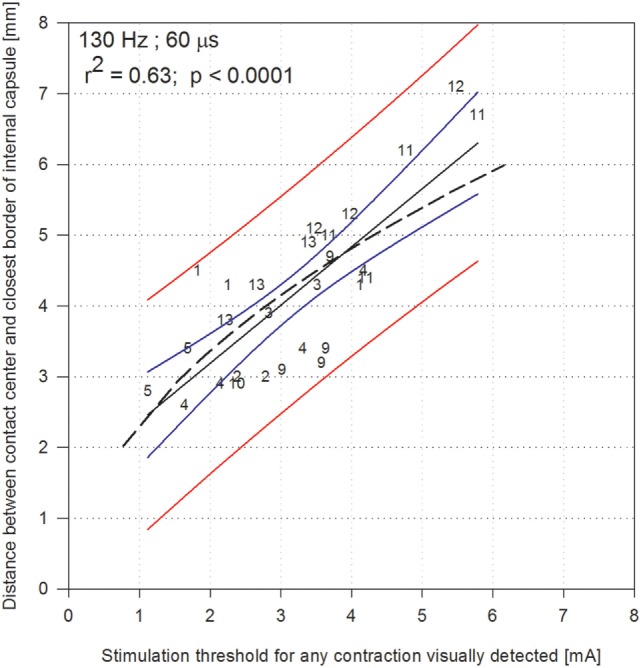
Shortest distance between the electrode contact and the corticospinal/corticobulbar tracts (internal capsule), according to the stimulation thresholds expressed in current [milliamperes (mA)] obtained for each contact at 130 Hz with 60 µs pulse duration, when contractions were visually detected. Numbers refer to each of the 12 patients (patient 7 excluded, numbers go from 1 to 13). The model of Kuncel et al. is indicated in dashed line; it was adapted for stimulation currents considering an average impedance of 1,300 Ω. The black line indicate the linear regression, the blue lines indicate 95% confidence band of the regression, and the red lines indicate the 95% prediction band.